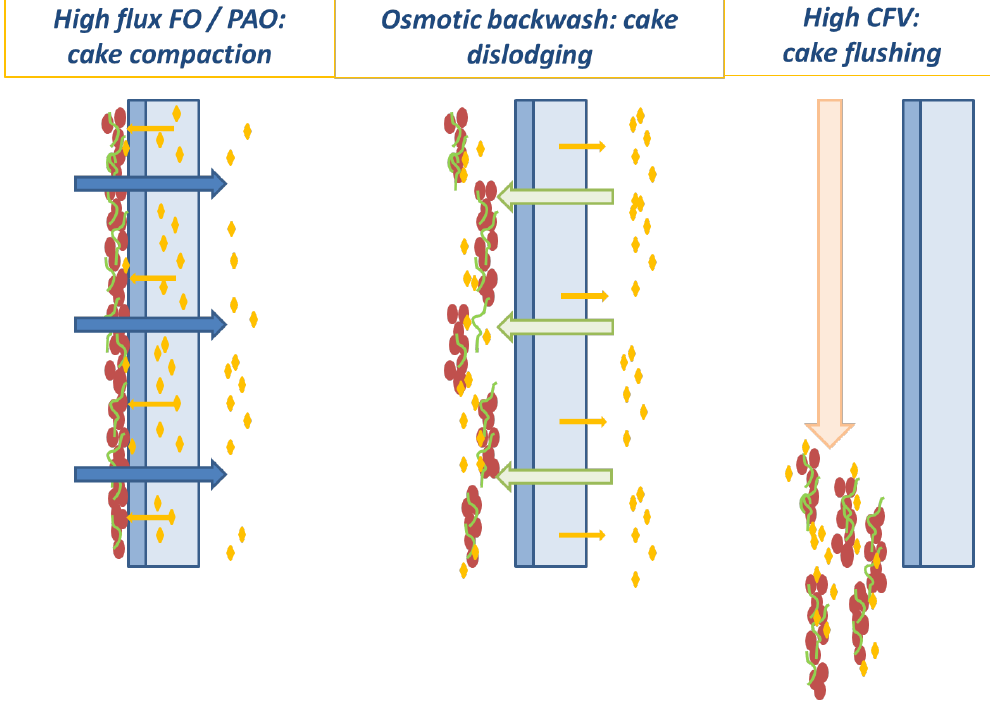
Figure 8. High flux FO and PAO fouling and cleaning (osmotic backwash and high cross-flow velocity flushing (adapted from [150]).